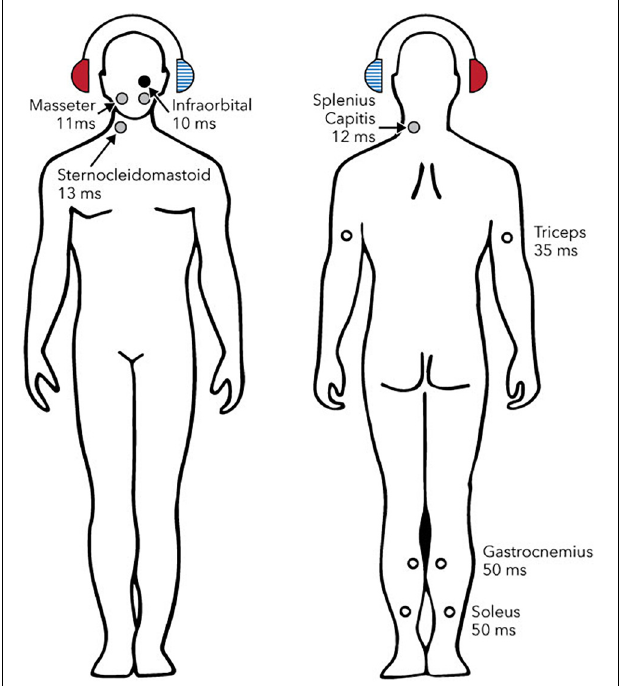
FIGURE 1 | Reflexes evoked by sound or vibration in postural muscles. Circles show sites, laterality and approximate latencies based on air-conducted stimulation. The right ear (solid red headphone) is the stimulated side. Solid circles show reflexes whose polarity has been confirmed with intramuscular recordings (black: excitatory; grey: inhibitory). Open circles show reflexes whose polarity has either not been definitively determined (triceps and gastrocnemius) or is known to depend upon head position (soleus). Reproduced from Rosengren and Colebatch (2018), see original for references to supporting studies. Creative Commons Attribution License